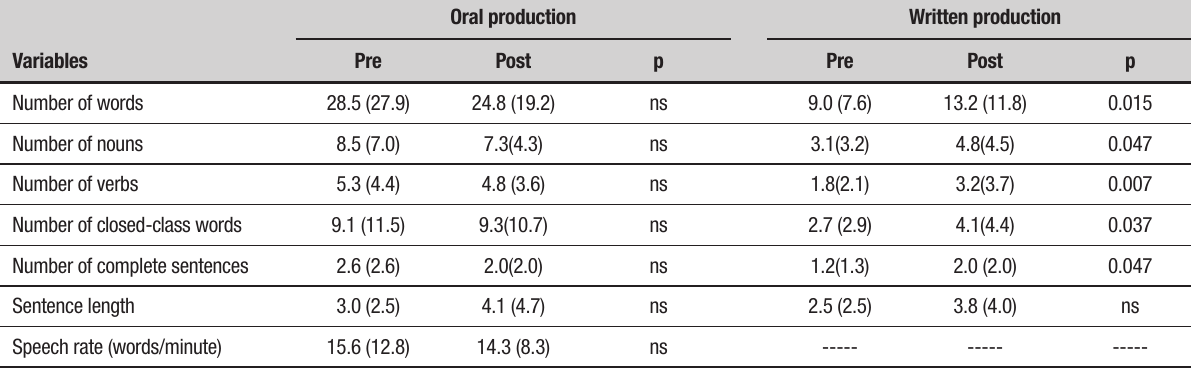
Table 2. Performance of subjects at pre and post-treatment using Mapping Therapy.